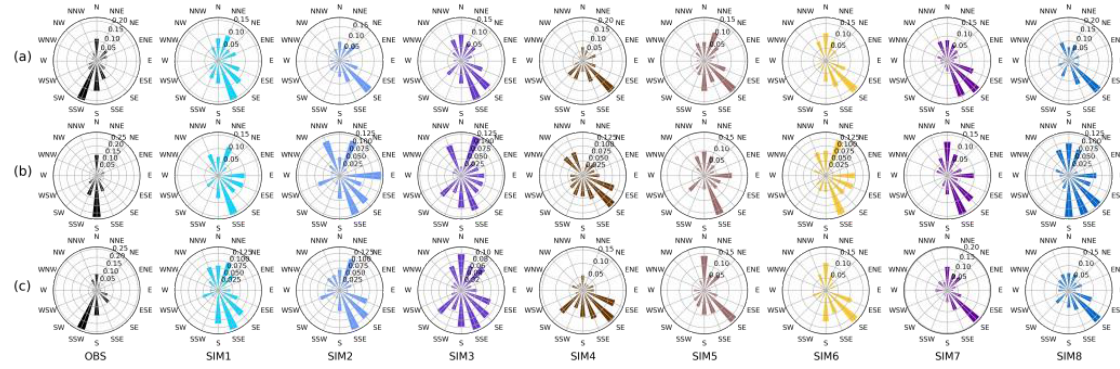
Figure 9. Rose diagram of simulated and observed 10-m wind directions in different schemes for the simulated time period at ( a ) Rongcheng: 54,503, ( b ) Xiongxian: 54,636, and ( c ) Anxin: 54,605. Table 5. The 10-m wind direction in the Xiongan New Area from observations and eight combined scheme